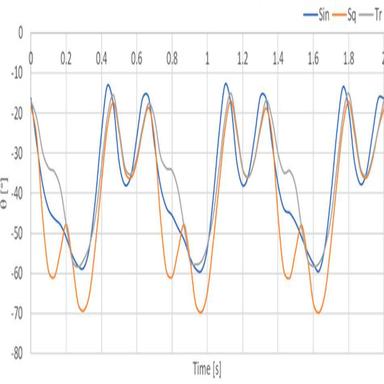
Rotation angle data under 10 psi, 1.5 Hz, and unload condition.